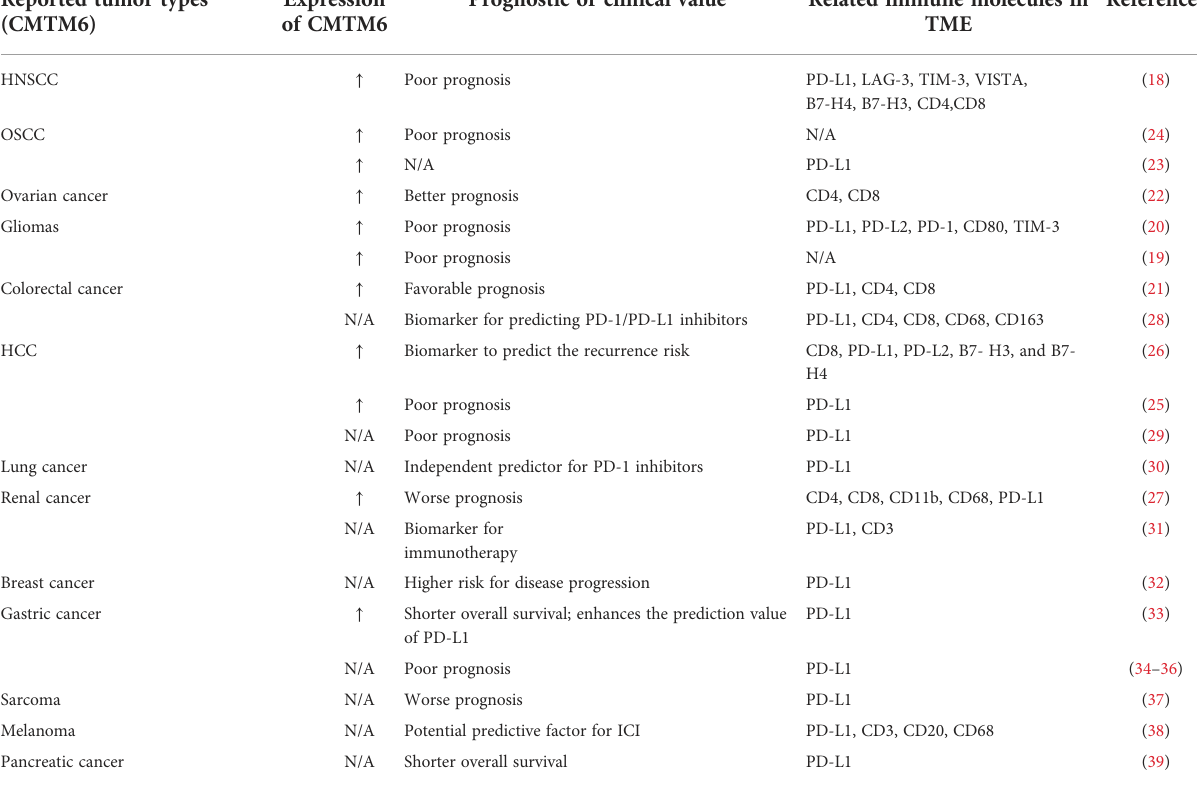
TABLE 1 Correlation of CMTM6 expression in different tumors with clinical prognosis and immune molecules in TME. Reported tumor types